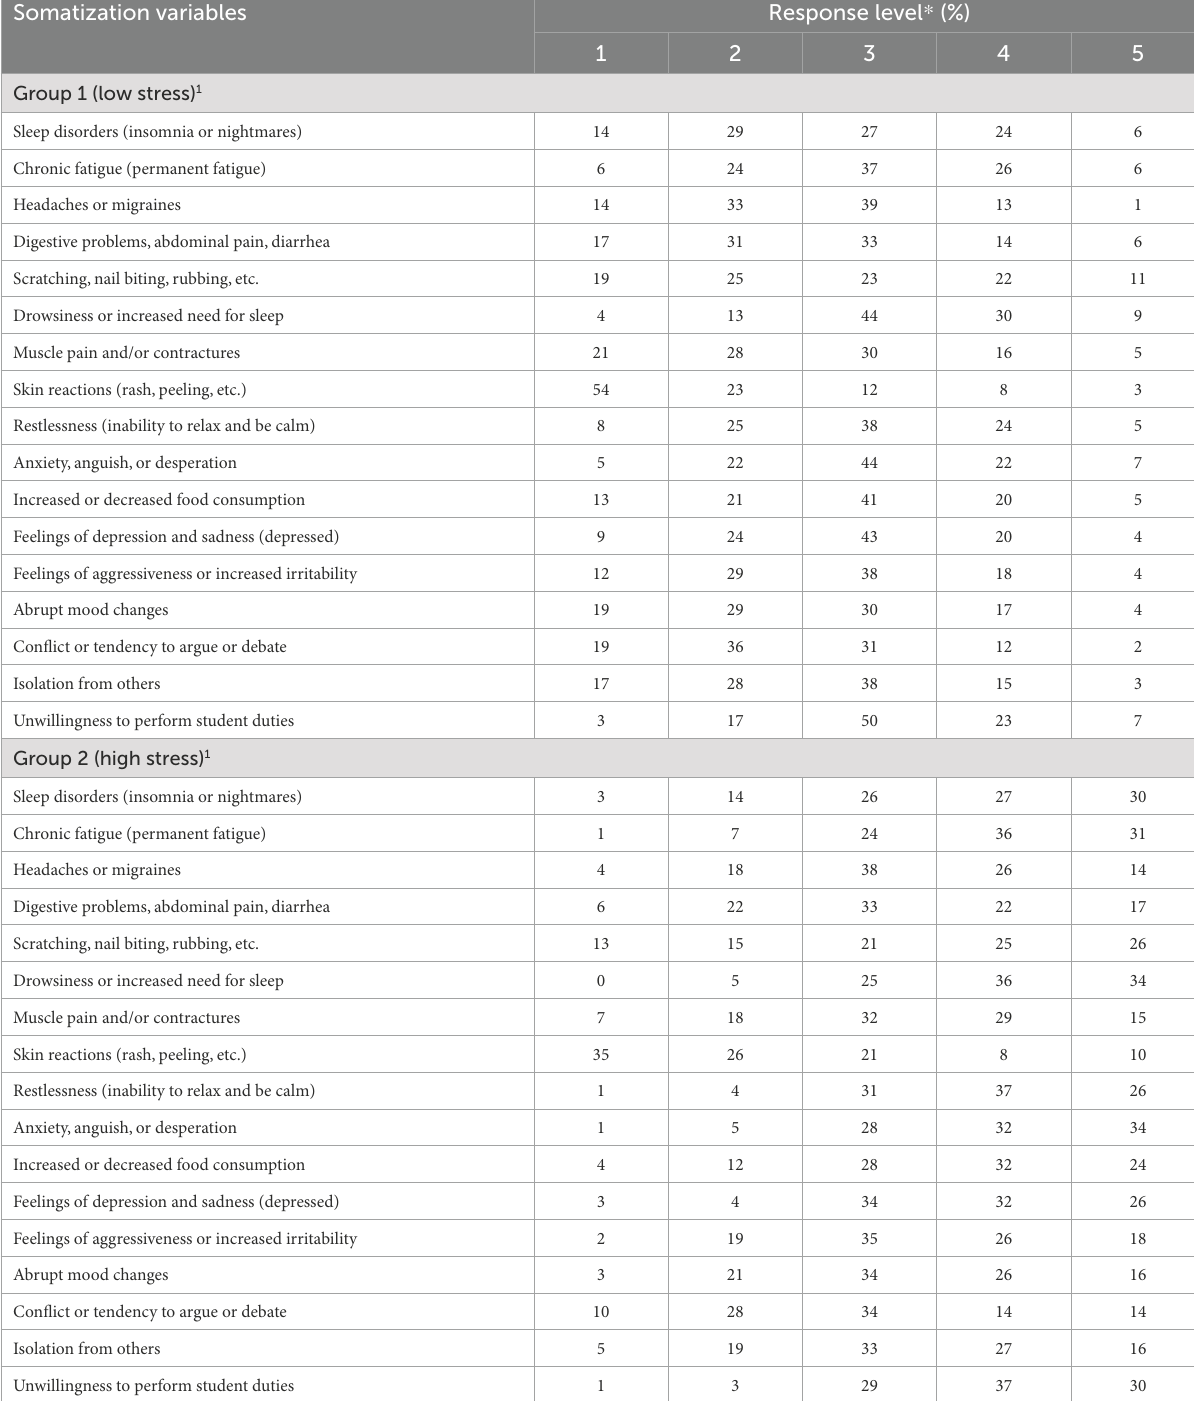
TABLE 5 Distribution of somatization variables by response level by stress groups. Somatization